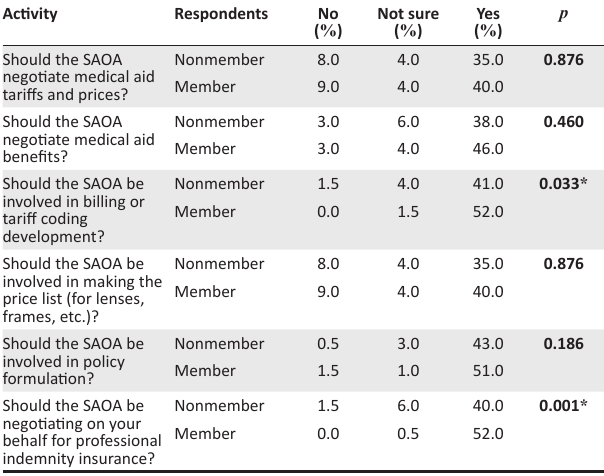
TABLE 1: Respondents’ opinions on the role of the South African Optometric Association in advocacy activities. Activity